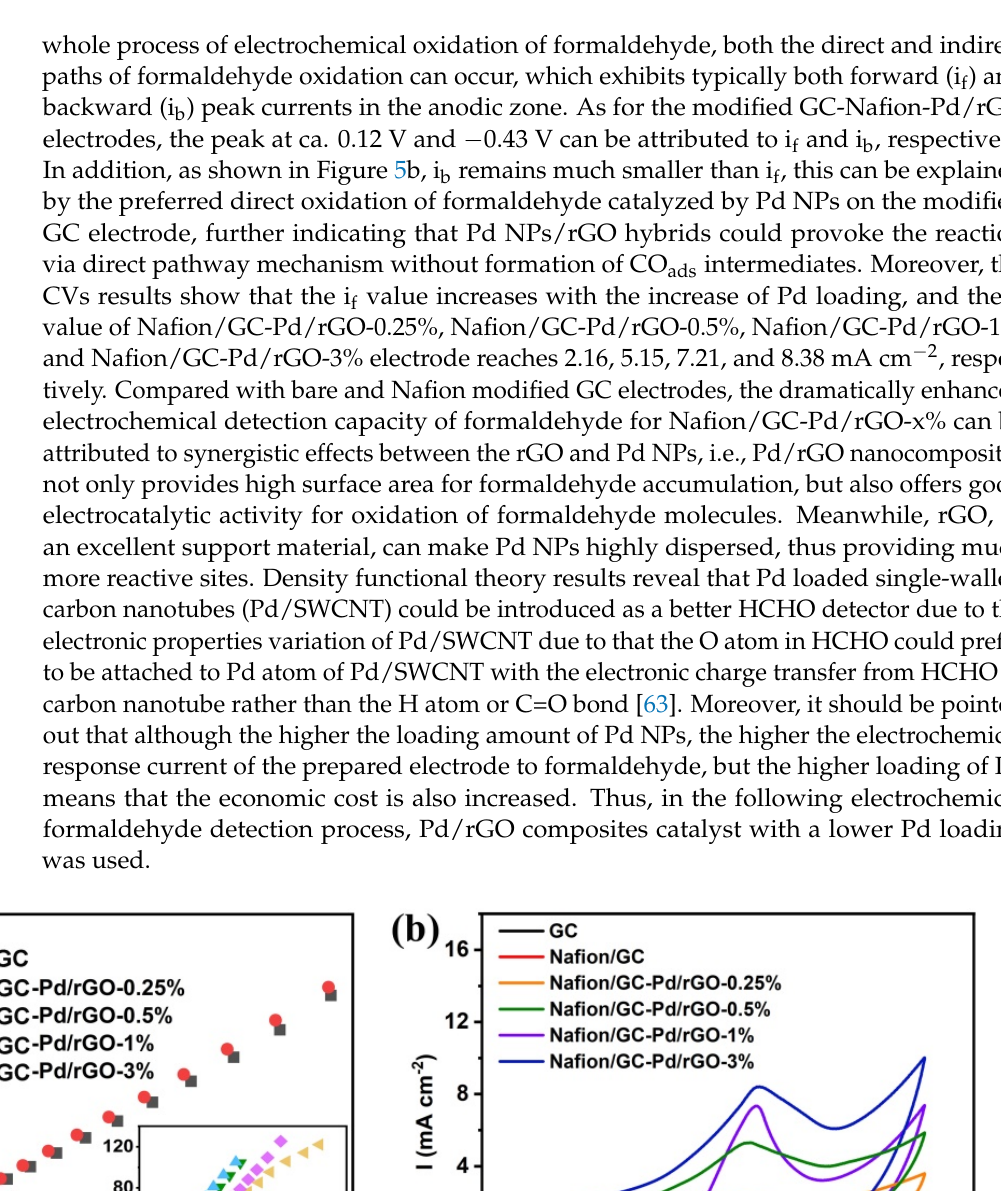
Scheme 1. Schematic illustration of oxidation of formaldehyde. Based on the above electrochemical measurements, it is found that the prepared Pd/rGO nanocomposites could serve as highly efficient electrocatalysts for the oxidation of formaldehyde. Although the detection limit temporary reaches only 2 mM under our current experimental conditions, the oxidation of formaldehyde reached at relatively low overpotential, which is more competitive in formaldehyde detection electrodes, such as platinum and palladium electrodes. Table 1 shows the comparison of the electrocatalytic behavior of as-prepared Pd/rGO for formaldehyde oxidation with some previously re- ported electrodes. The peak potential for the oxidation in our work is much less than that of reported electrodes. To the best of our knowledge, no electrochemical sensors for de- termination of formaldehyde using Pd or Pt based catalysts can be achieved at such a low overpotential and Pd loading amount. These results confirm the feasibility of the fabri- cated electrode for the quantitative detection of certain concentration of formaldehyde in aqueous solution. In order to highlight the excellent chemical reactivity of the prepared Pd/rGO samples, graphite powder was used as another carbon support to prepare Pd/C by the impregnation-sodium borohydride reduction method (the theoretical loading of Pd was 0.5 wt%), and evaluated its catalytic hydrogen production from formaldehyde and electrochemical formaldehyde detection performance, and the results are shown in Figure S10a,b. Under the same reaction conditions, although Pd/C exhibited higher hydrogen production activity than pure Pd NPs, its hydrogen production within 30 min was still much lower than that of Pd/rGO-0.5%. For the electrochemical detection performance of formaldehyde in alkaline medium, Nafion/GC-Pd/C electrode exhibited a current density of 2.68 mA cm − 2 , which was still much lower than that of Pd/rGO. In addition, its detection